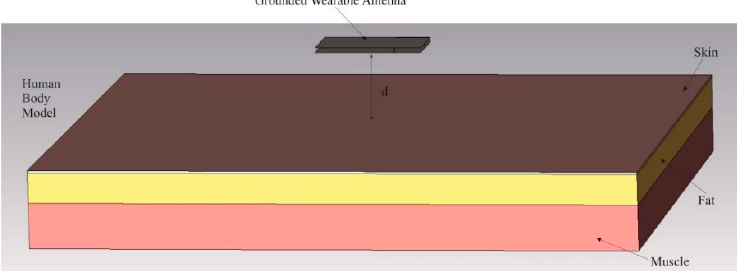
Figure 1. A wearable antenna on the phantom model used to perform the numerical investigation of the antenna robustness to the body proximity.